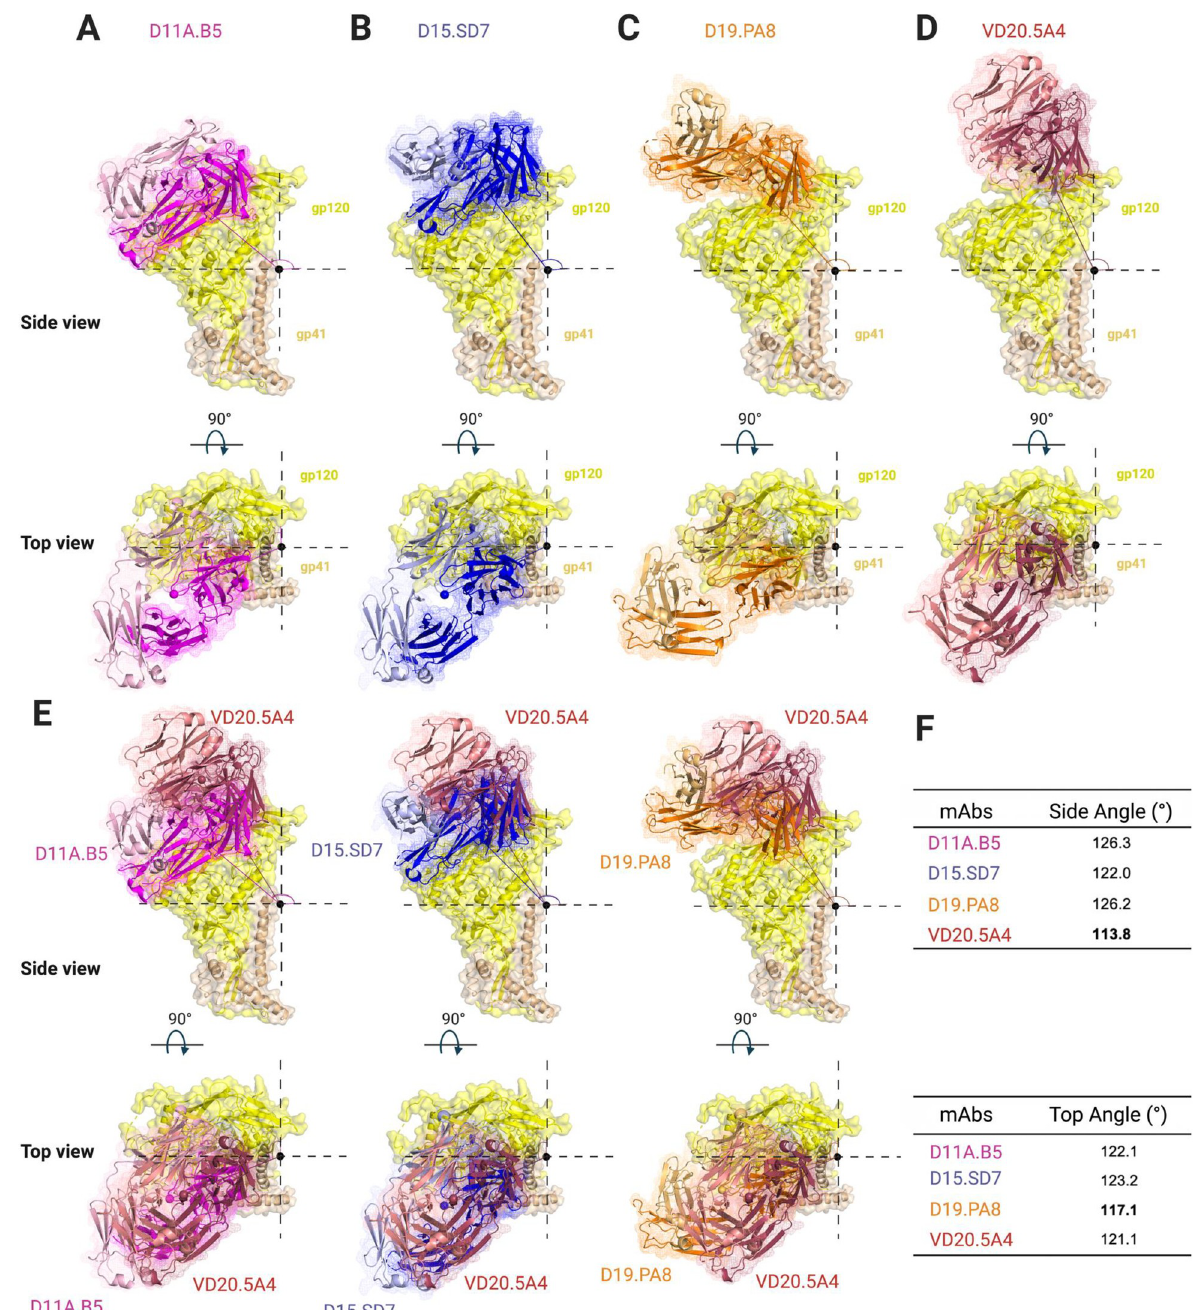
Fig 6. Vaccine-elicited mAbs target V2 region using a lateral approach with slightly different angles of approach. Side and top surface/cartoon representation of one gp120 (yellow)-gp41 (tan) 16055 NFL protomer with Fab bound: ( A ) D11A.B5 (pink), ( B ) D15.SD7 (blue), ( C ) D19.PA8 (orange) and ( D ) VD20.5A4 (raspberry) showing the angles of approach of each mAb. ( E ) Superimposition of gp120-gp41 16055 NFL protomer with D11A.B5 (pink), D15.SD7 (blue) and D19.PA8 (orange) onto VD20.5A4-bound gp120-gp41 protomer. ( F ) Summary of the mAbs angles of